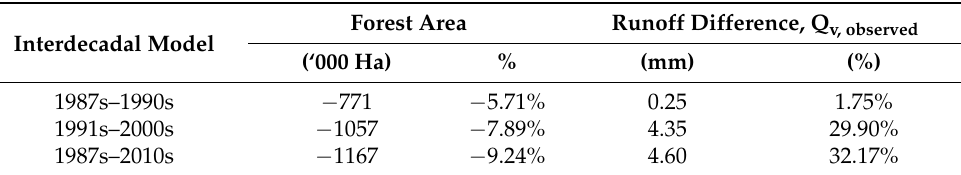
Table 8. The decadal changes in the amount and the corresponding percentage of forest area and runoff difference in East Malaysia.